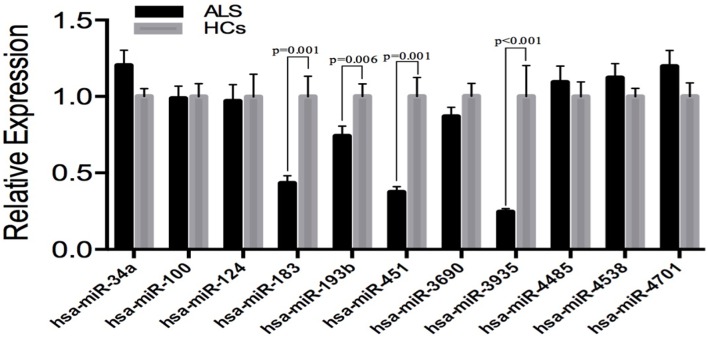
Validation of miRNAs expression by qRT-PCR analysis in leukocytes samples from SALS (n = 83) and HCs (n = 61). Data are represented by bar chart. The P-values were calculated by the Mann-Whitney U-test. The relative expression of miRNAs in HCs was normalized.